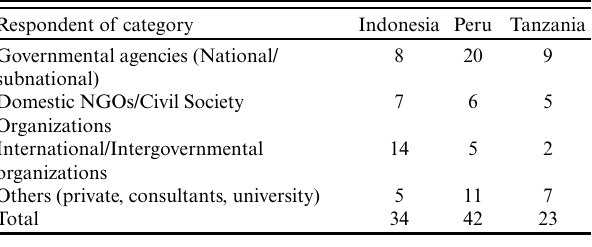
Table 1 . Number of interviewees by category by